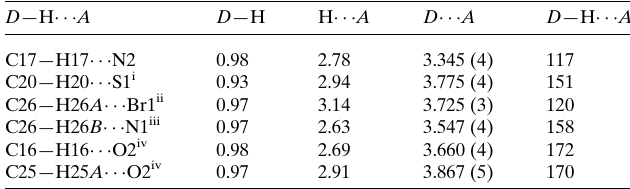
Table 1 Hydrogen-bond geometry (A˚ , (cid:2) ).